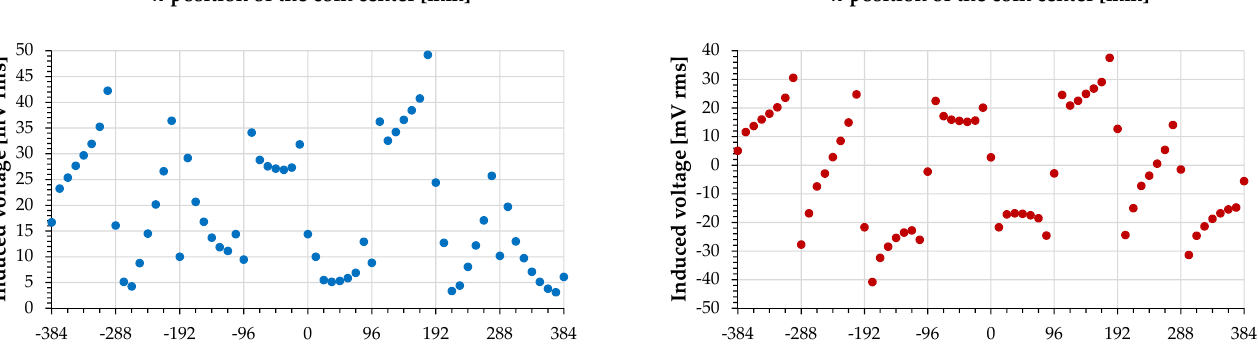
Figure 8. Output signals of the sensor coils depending on the position of the test object 1 ( top ) Signals of the sensor coil 2 ( bottom ) Signals of the sensor coil 6 ( left ) Actual measured signal amplitudes ( right ) Calculated influence of the test object taking into account offset voltage and phase angle.